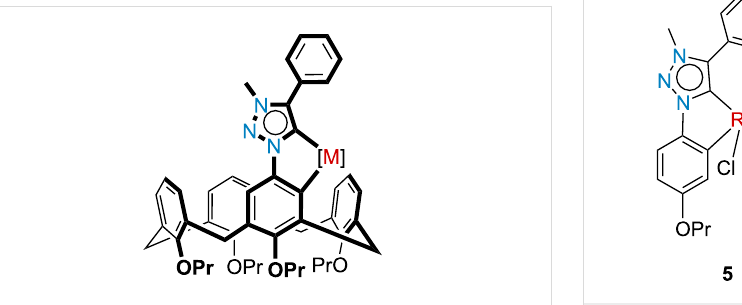
Incorporation of a mesoionic carbene directing group onto the upper rim of a calix[4]arene therefore offered potential for a new route to calix[4]arene C–H activation. Spontaneous cyclometalation of the MIC-functionalized calix[4]arene with a transition metal would provide access to a new type of meta - functionalized inherently chiral calix[4]arene (see Figure